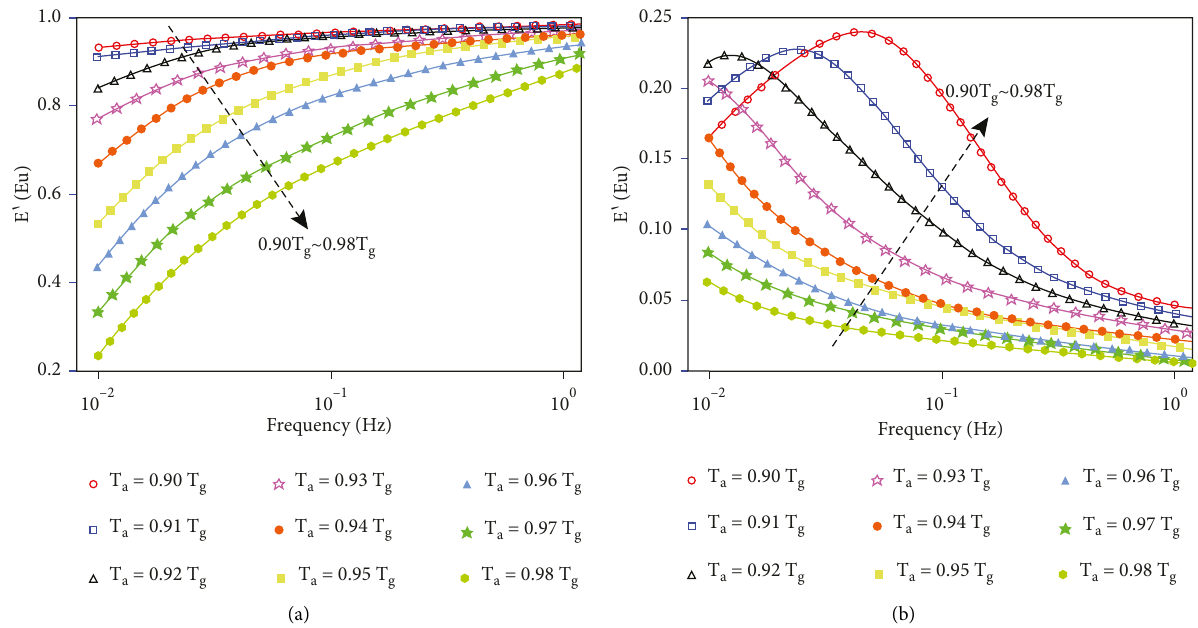
Figure 6: The trend of normalized (a) storage modulus and (b) loss modulus of ZrCoAlNi as a function of applied frequency.